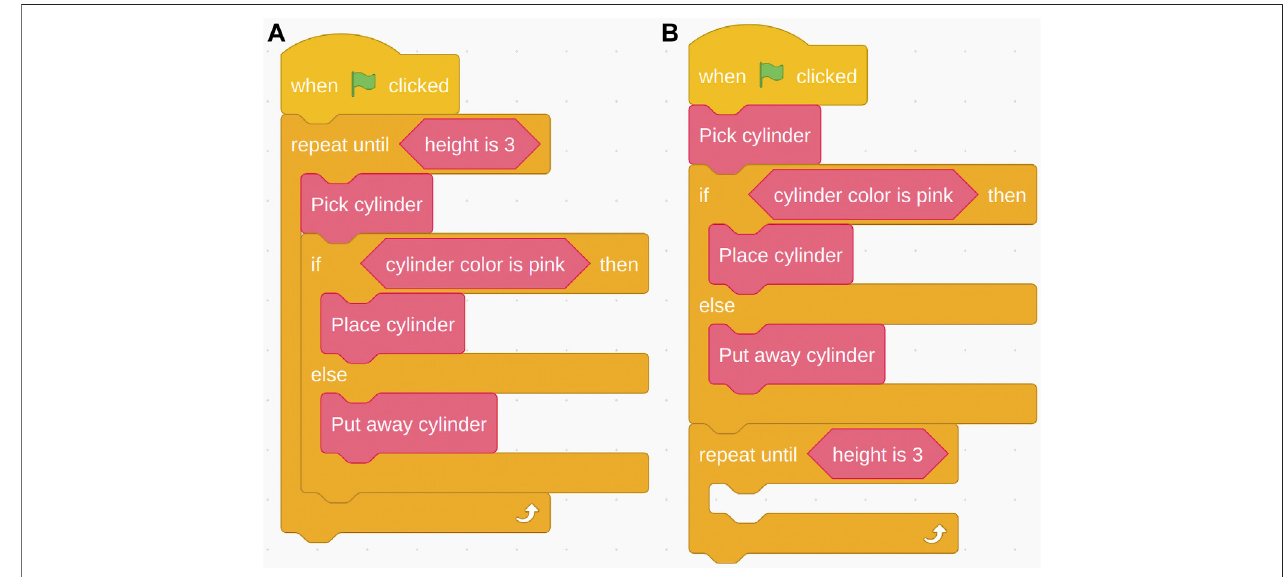
FIGURE 8 | Pick-and-Place task: Correct program (A) and the loop incorrectly placed at end of program rather than around the “ if-else ” conditional (B) .